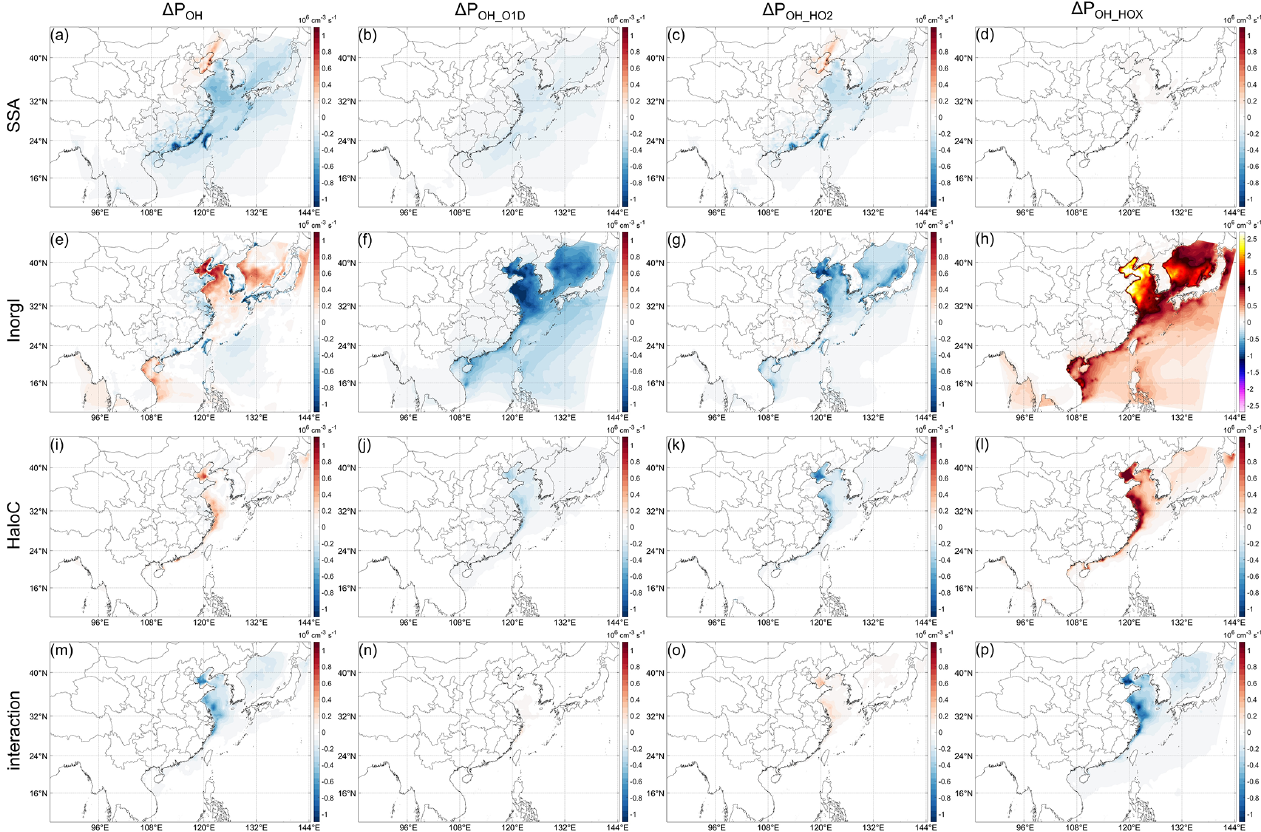
Figure 4. Decomposition of Fig. 3 for different halogen species. Panels (a) – (d) , (e) – (h) , and (i) – (l) are results for the SSA, InorgI, and HaloC cases, respectively. Panels (m) – (p) are the residue between All_high and SSA + InorgI + HaloC, representing the interactions of different halogen species. The red and blue color scales are the same in (a) – (p)